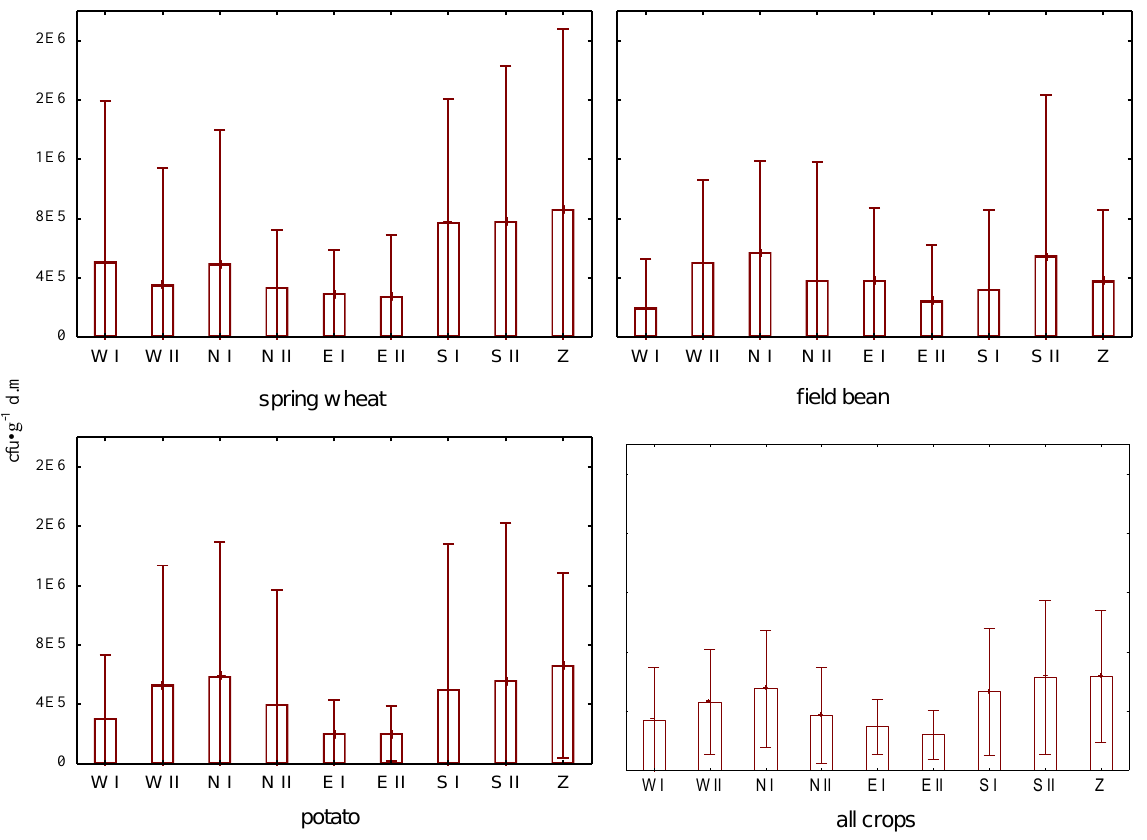
Figure 2. The total numbers of bacterial sporulating forms (cfu g − 1 dry soil) in the soil near the municipal landfill site (columns—mean values, whiskers—mean concentration ± standard deviation). For description of sampling sites see Table 1. Table 3. The numbers of bacterial sporulating forms in the soil under the cultivation of agricultural plants in the area surrounding the municipal landfill site [ × 10 4 cfu · g − 1 dry